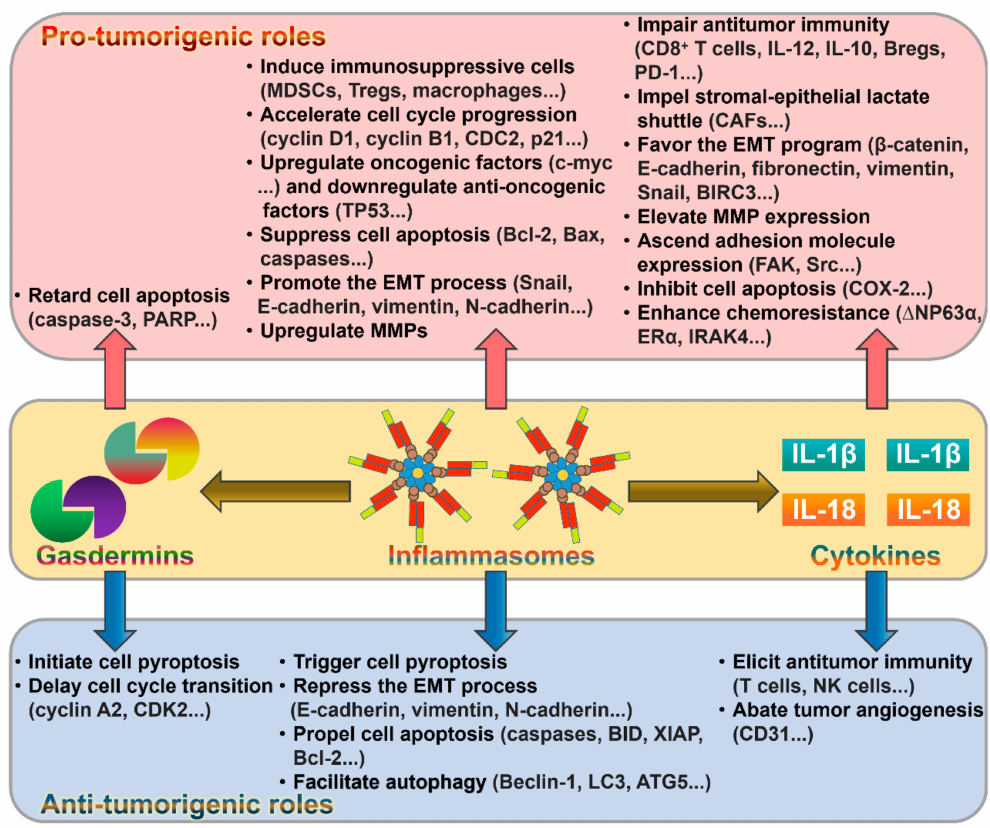
Figure 2. Overview of the roles of the pyroptotic pathways in cancer. The major components (inflammasomes, gasdermins and inflammatory cytokines) involved in pyroptotic cell death pathways can either promote or restrain cancer progression. Their pro-tumorigenic mechanisms primarily include induction of immunosuppressive cells, impairment of antitumor immunity, suppression of cell apoptosis, and promotion of the EMT program. Promotion of cell death, repression of the EMT process and induction of antitumor immunity represent pivotal mechanisms mediating the anti-tumorigenic roles of the pyroptotic pathways. PARP, poly (ADP-ribose) polymerase; MDSCs, myeloid-derived suppressor cells; Tregs, regulatory T cells; CDC2, cell division cycle 2; TP53, tumor protein p53; Bcl-2, B-cell lymphoma-2; Bax, Bcl-2-associated X protein; EMT, epithelial-mesenchymal transition; MMPs, matrix metalloproteinases; IL-12, interleukin-12; IL-10, interleukin-10; Bregs, regulatory B cells; PD-1, programmed cell death-1; CAFs, cancer-associated fibroblasts; BIRC3, baculoviral inhibitor of apoptosis repeat-containing 3; FAK, focal adhesion kinase; COX-2, cyclooxygenase-2; ∆ NP63 α , tumor protein 63 (TP63) isoform; ER α , estrogen receptor α ; IRAK4, interleukin-1 receptor-associated kinase 4; CDK2, cyclin-dependent kinase 2; BID, Bcl-2 homology domain 3 (BH3)-interacting domain death agonist; XIAP, X-linked inhibitor of apoptosis protein; LC3, microtubule-associated protein light chain 3; ATG5, autophagy-related gene 5; NK cells, natural killer